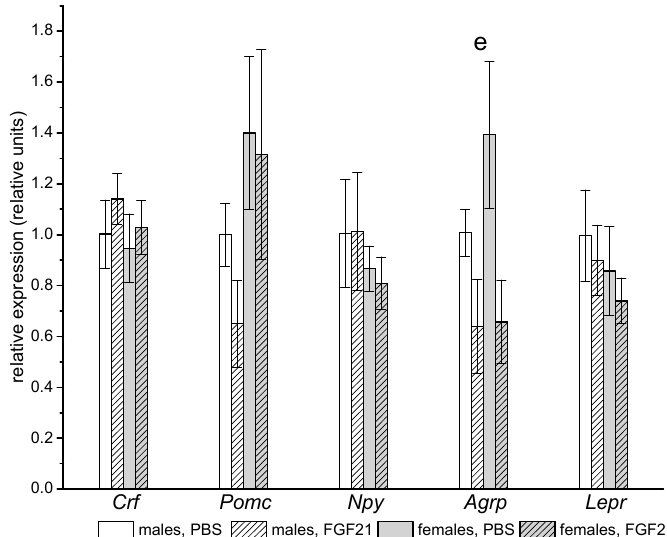
Figure 6. Influence of FGF21 administration on hypothalamic gene expression in male and female obese mice. Data are presented as mean ± SEM. Mice were administered FGF21 for 7 days. Significant influence of factor “e” (administration of PBS or FGF21), two-way ANOVA, is indicated in the plot.